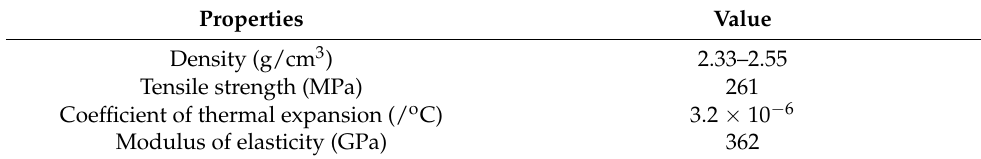
Table 4. Properties of B 4 C [35].